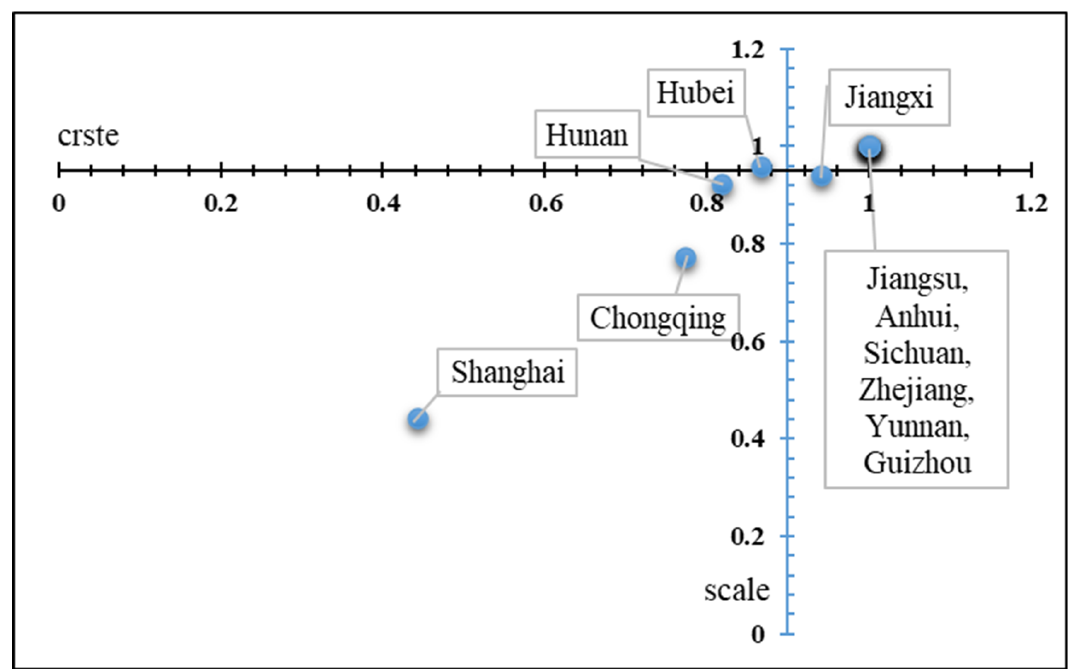
Figure 7. A comprehensive efficiency decomposition diagram of the YREB in 2019.